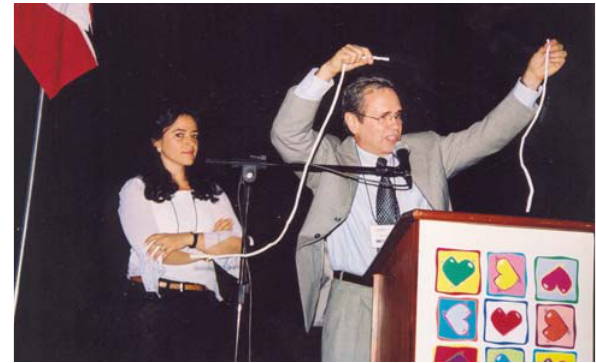
Fig.2 - Dr. José Carlos de Andrade “fazendo mágica” durante